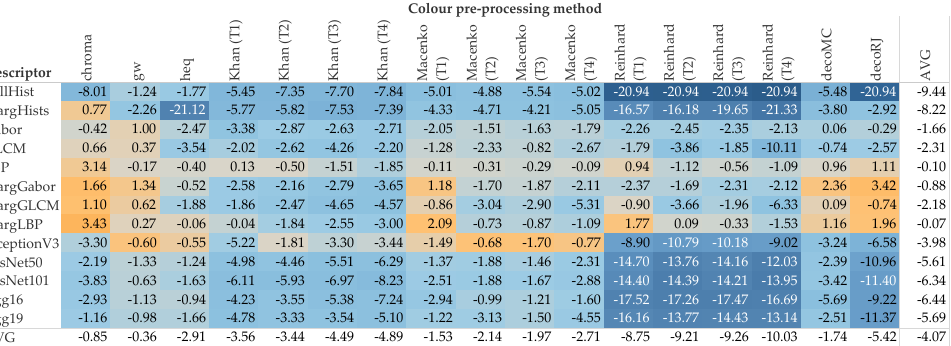
Figure 7. Difference to the baseline by image descriptor and pre-processing method. The values are averaged over the eight data set and filtered on f = 4. Baseline is the condition where no color pre-processing is applied.